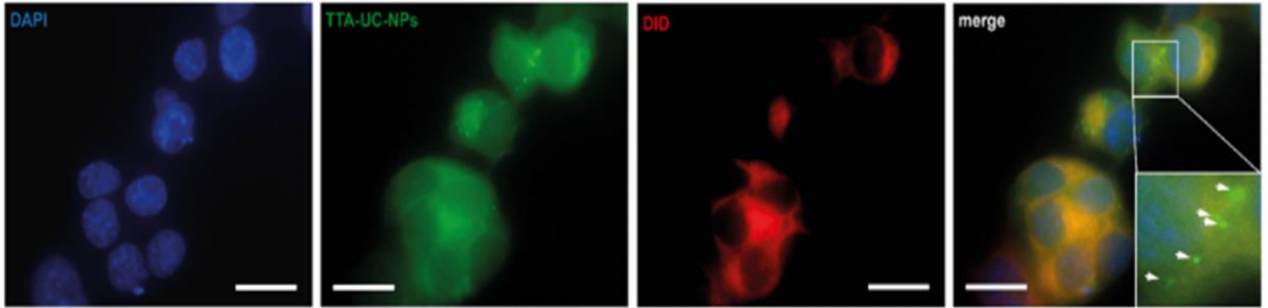
Figure 5. Cellular uptake of TTA-UC-PLGA-NPs. OVCAR-3 cells were incubated with 200 µ g/mL TTA-UC-PLGA-NPs for 2 h at 37 ◦ C and analysed by fluorescence microscopy. The cells were fixed, and the nucleus was stained with DAPI (blue) and the cell membrane was stained with DiD (red). The phosphorescence signal (green) of the TTA-UC-PLGA-NPs was collected. The following filter cubes were used to discriminate DAPI, DiD and TTA-UC-PLGA-NP-signals: DAPI, λ exc = 340–380 nm and λ emi = 425 nm; DiD, λ exc = 676–688 nm, λ emi = 700–742 nm; TTA-UC-PLGA-NPs, λ exc = 542–582 nm, λ emi 604–644 nm. Scale bar = 20 µ